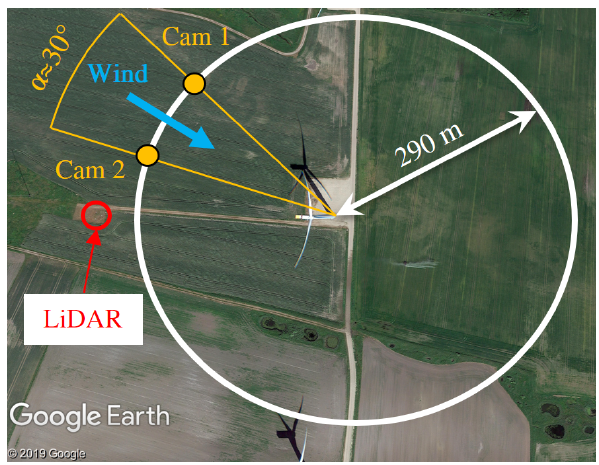
Figure 2. Experimental set-up at the Høvsøre wind turbine test site.